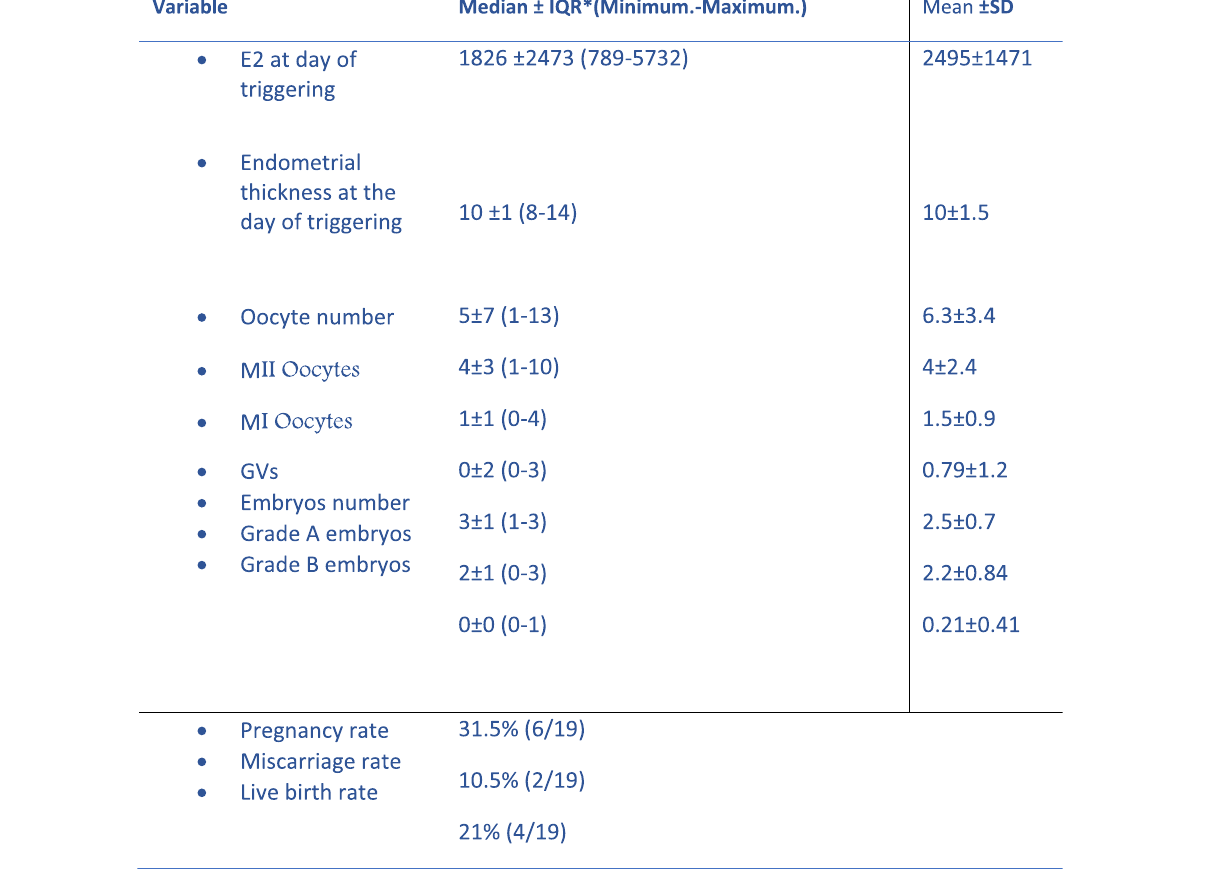
Table 2 The outcomes after stimulation in the studied